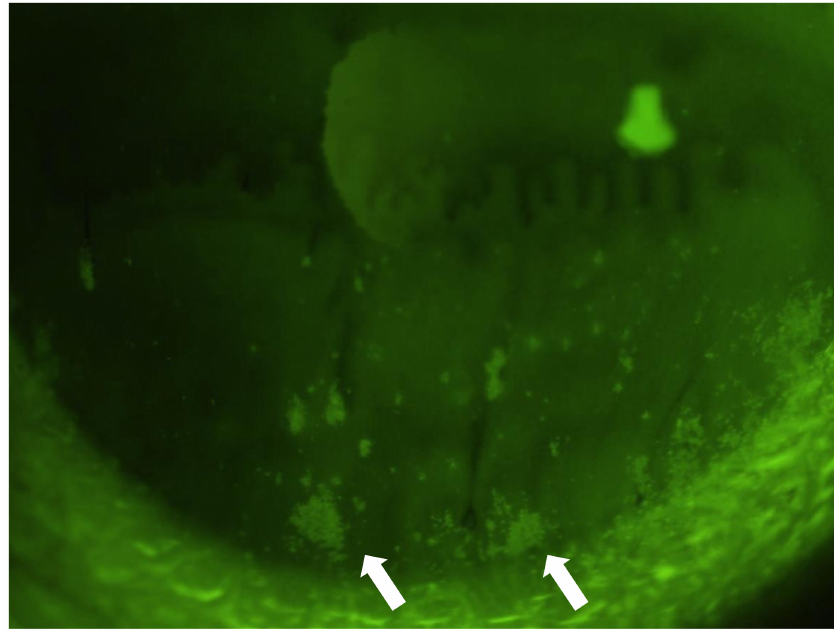
Figure 1. Slit-lamp photograph of fluorescein “patchy pattern” corneal staining (PPCS). PPCS can be seen on the lower cornea (white arrows) as a mottled-pattern staining, quite unlike ordinary superficial punctate keratopathy